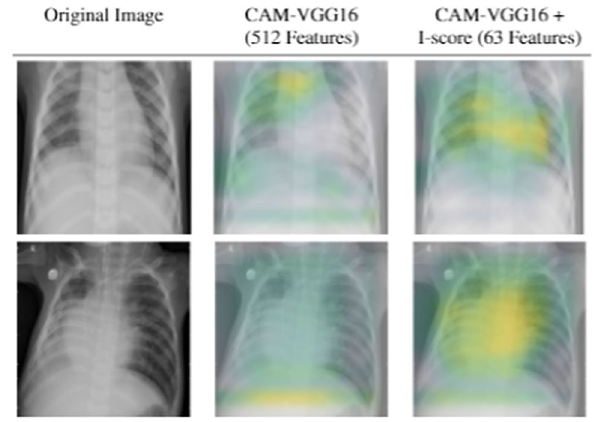
Fig. 2 The graph presents two samples using CAM visualiza- tion technique before and after using proposed method. This marks the direction of explainability that this paper tackles. We will see more intriguing results in the appli- cation